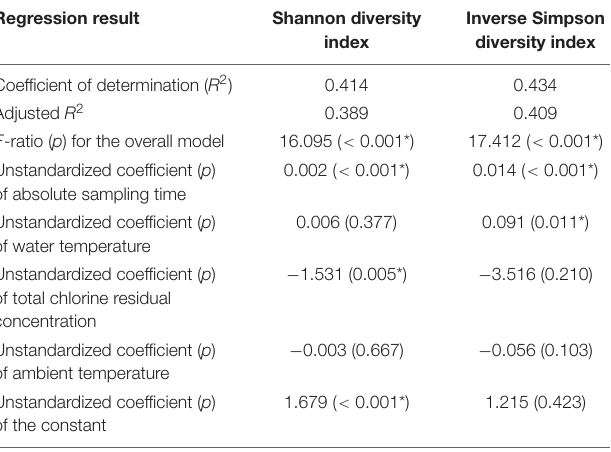
TABLE 1 | A multiple linear regression model predicting the Shannon and Inverse Simpson diversity indices of the water samples with four independent variables (absolute sampling time, water temperature, total chlorine residual concentration, and ambient